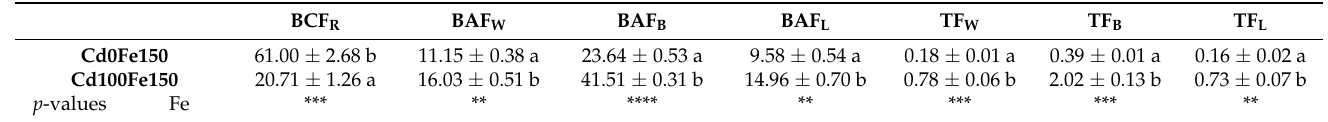
Table 1. BAF, BCF, and TF for Cd in the roots (R), woods (W), barks (B), and leaves (L) of poplar under different Cd and Fe combined treatments.